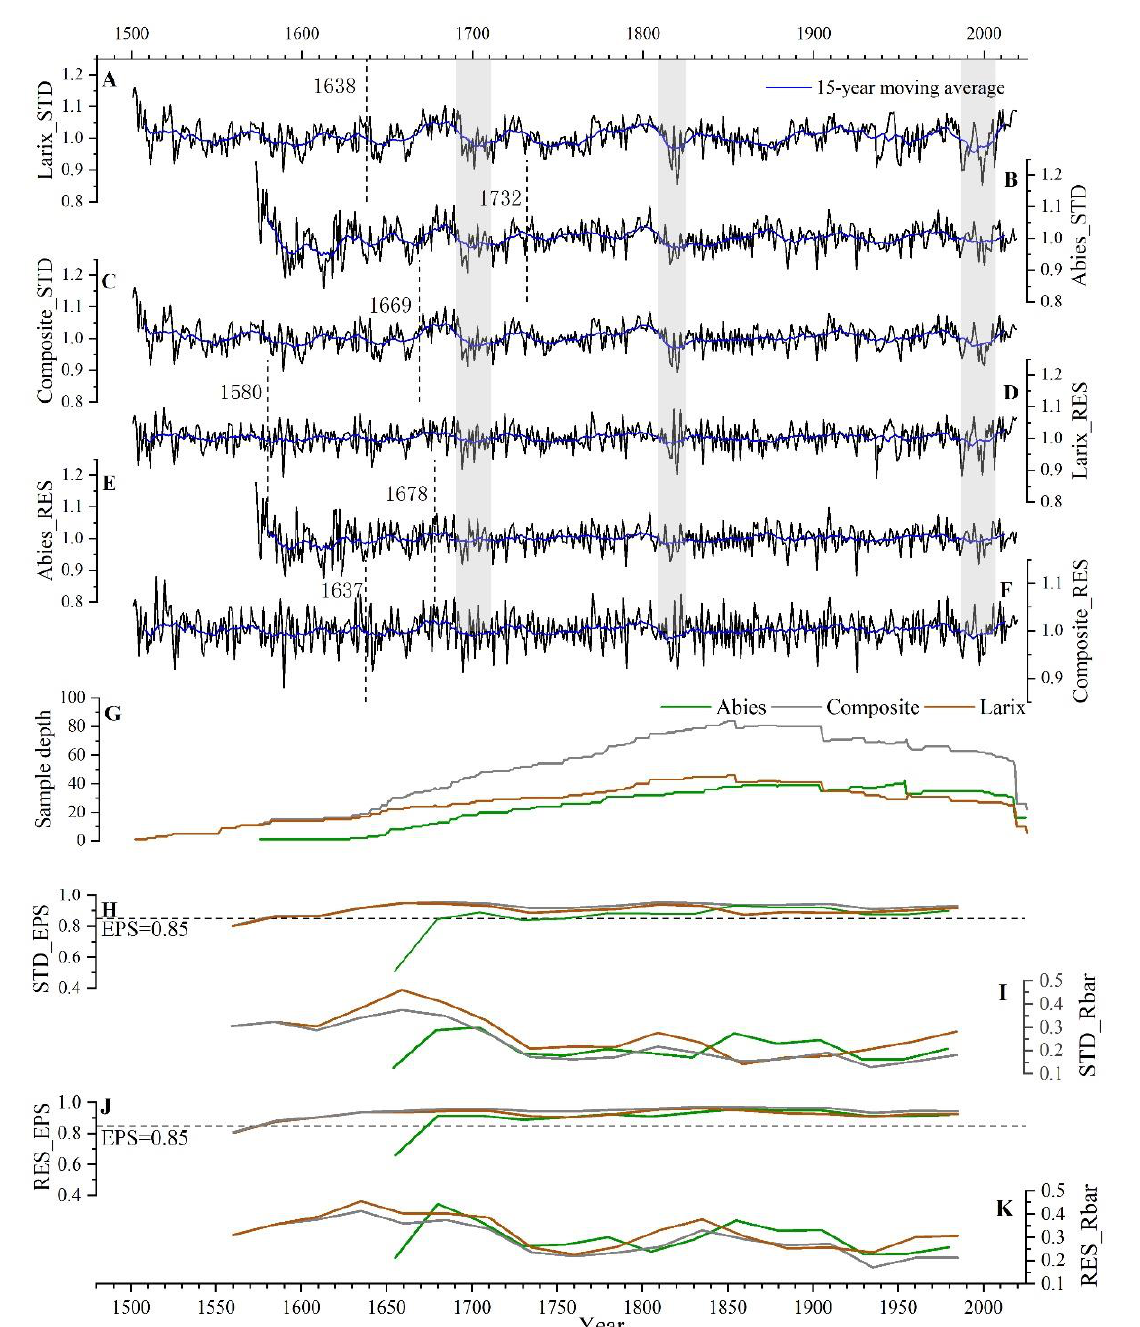
Figure 2. MXD Chronologies of L. speciosa and A. delavayi . ( A – C ) The standard chronologies. ( D – F ) The residual chronologies. ( G ) The sample depth of chronologies. ( H – K ) The running inter-series correlation (rbar) and the expressed population signal (EPS) were centered on a 50-year window with a 25-year step length. The dashed line is 0.85 cutoff. The gray shaded vertical areas indicated the low-index intervals of 15-year moving average of chronologies.